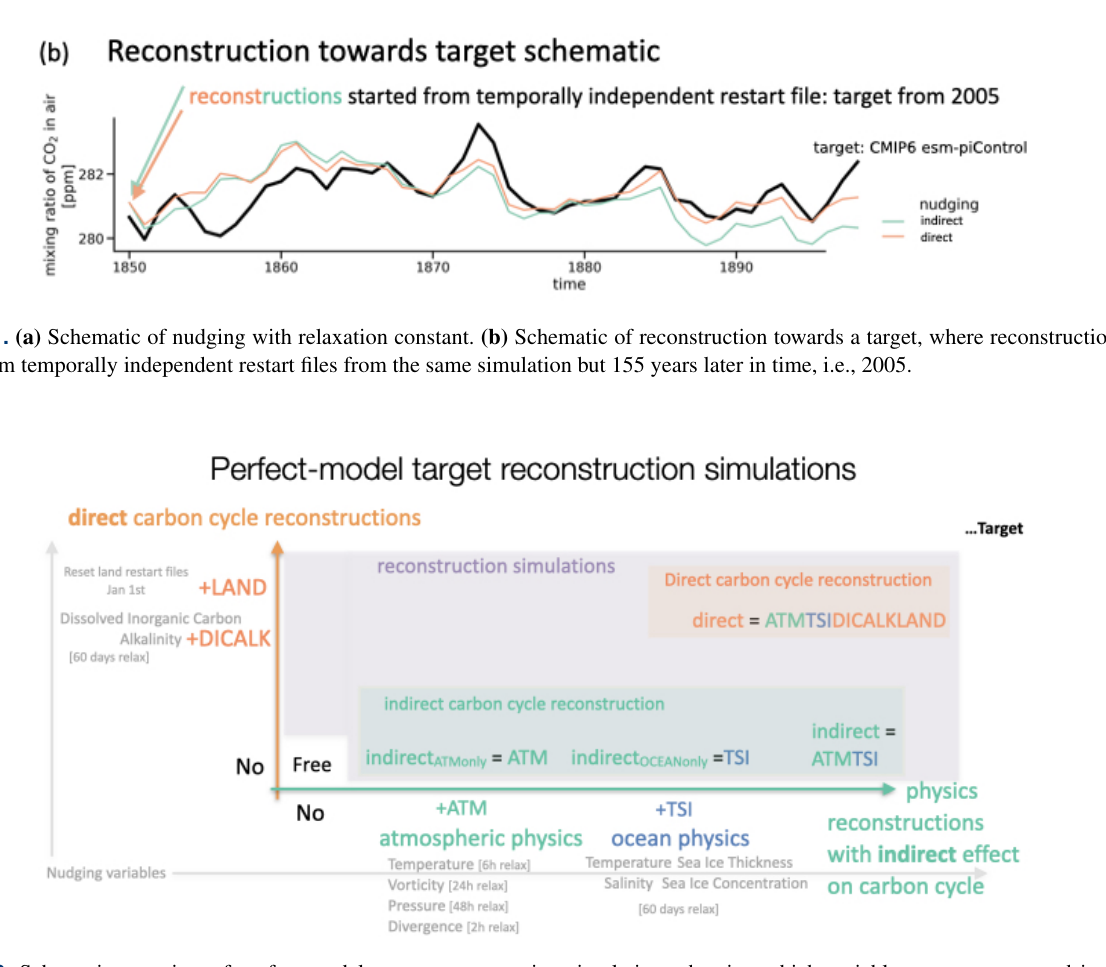
Figure F2. Schematic overview of perfect-model target reconstruction simulations showing which variables are reconstructed in which